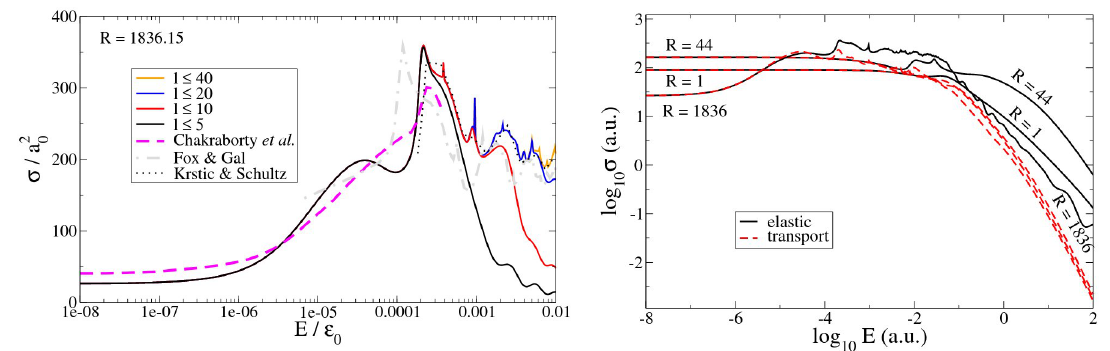
Figure 3: Left: Elastic scattering cross section of H atoms versus energy, in atomic units, from Ref. [ 17 ] . The convergence of the partial wave expansion is illustrated by summing different numbers of partial waves. Right: elastic and and transport cross sections versus energy, for several values of R = m